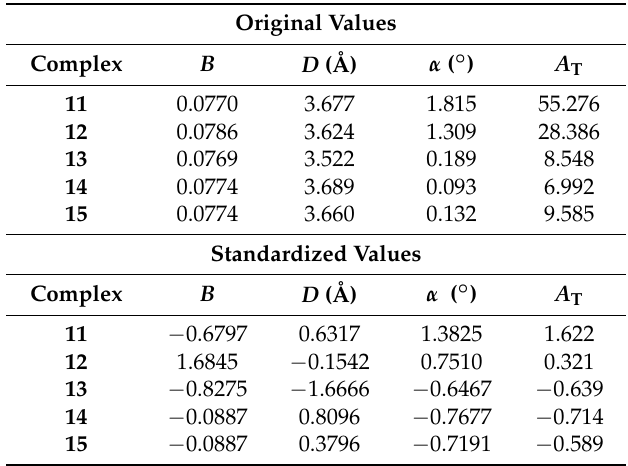
Scheme 5. The structures of phenanthrolinyliron complexes 11 – 15 . Table 5. The original and standardized values of bond order ( B ), minimum distance ( D ) and dihedral angle ( α ) along with thermal stability ( A T ) for complexes 11 – 15 , respectively.